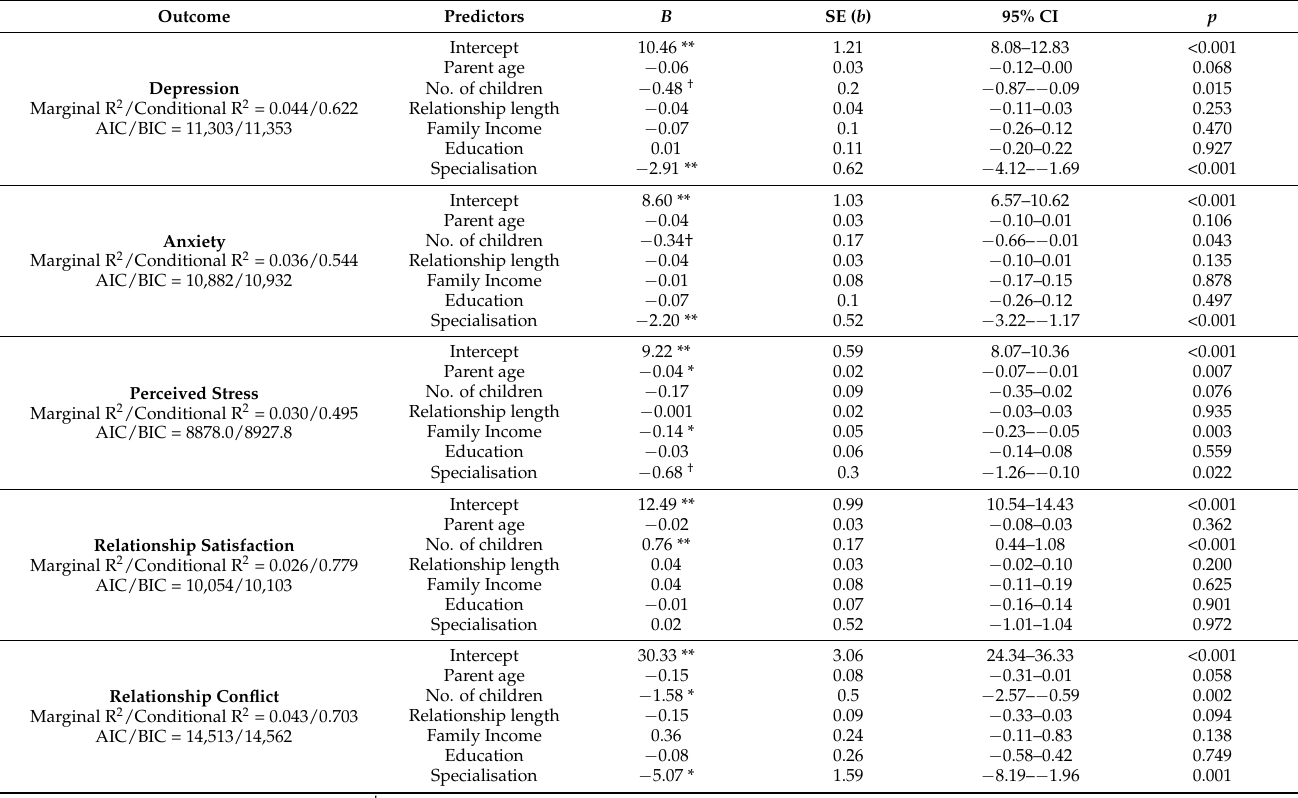
Table 3. Effects of specialisation on parents’ well-being.